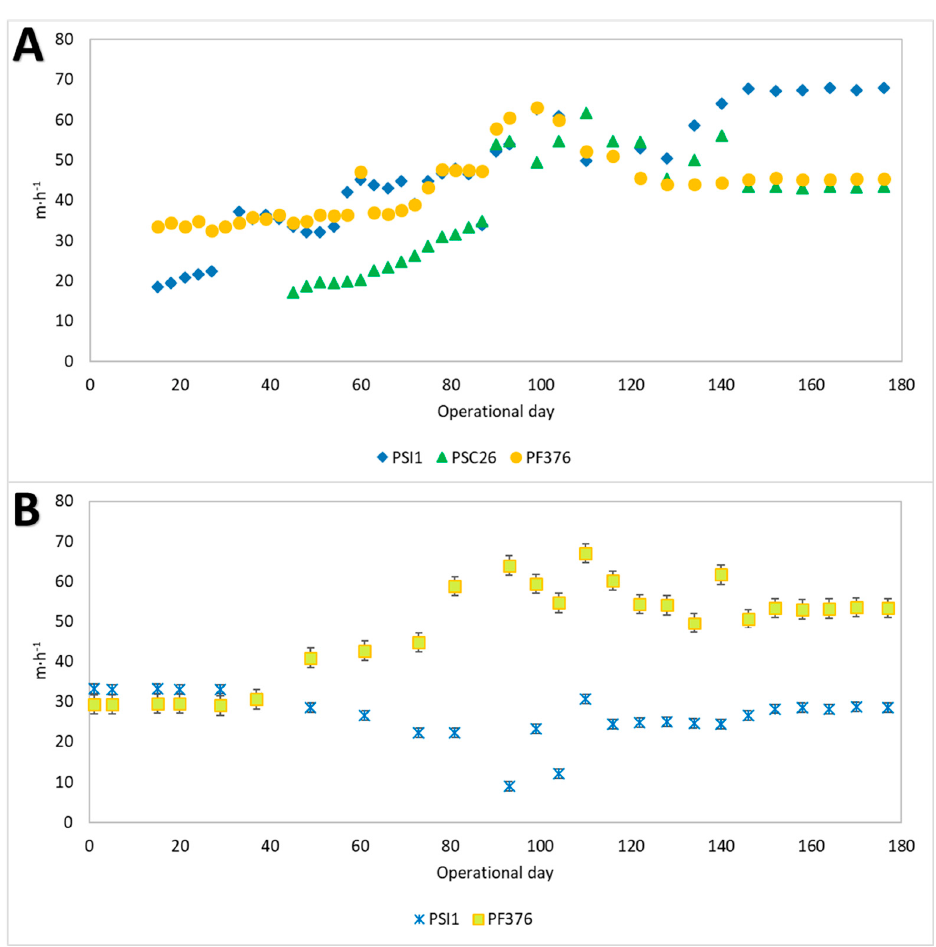
Figure 5. The settling velocity of granular biomass of Pseudomonas fluorescens PSC26 (PSC26), Pseu- domonas fluorescens 376 (PF376), and Pseudomonas stutzeri I1 (PSI1) fed with sodium acetate ( A ) and methanol ( B ).